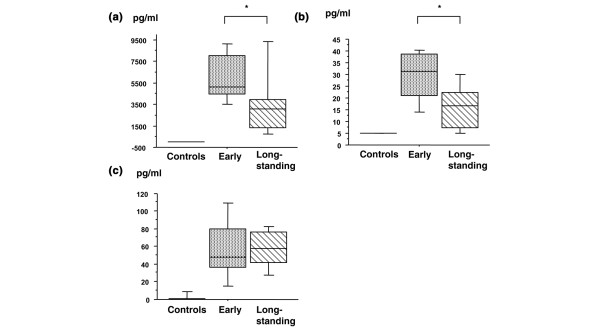
Box-whisker plots showing concentrations in synovial fluid for rheumatoid arthritis and healthy controls. (a) IL-6; (b) bombesin/gastrin-releasing peptide; (c) substance P. Boxes show the 25th and 75th percentiles; horizontal lines in boxes show the medians; whiskers show the 10th and 90th percentiles. *P < 0.05.